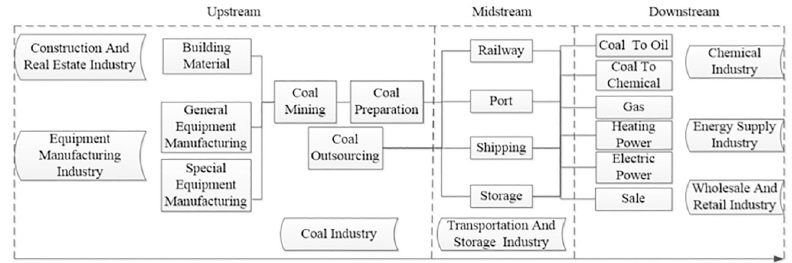
Fig 2. Vertical integration of coal enterprises along the industry